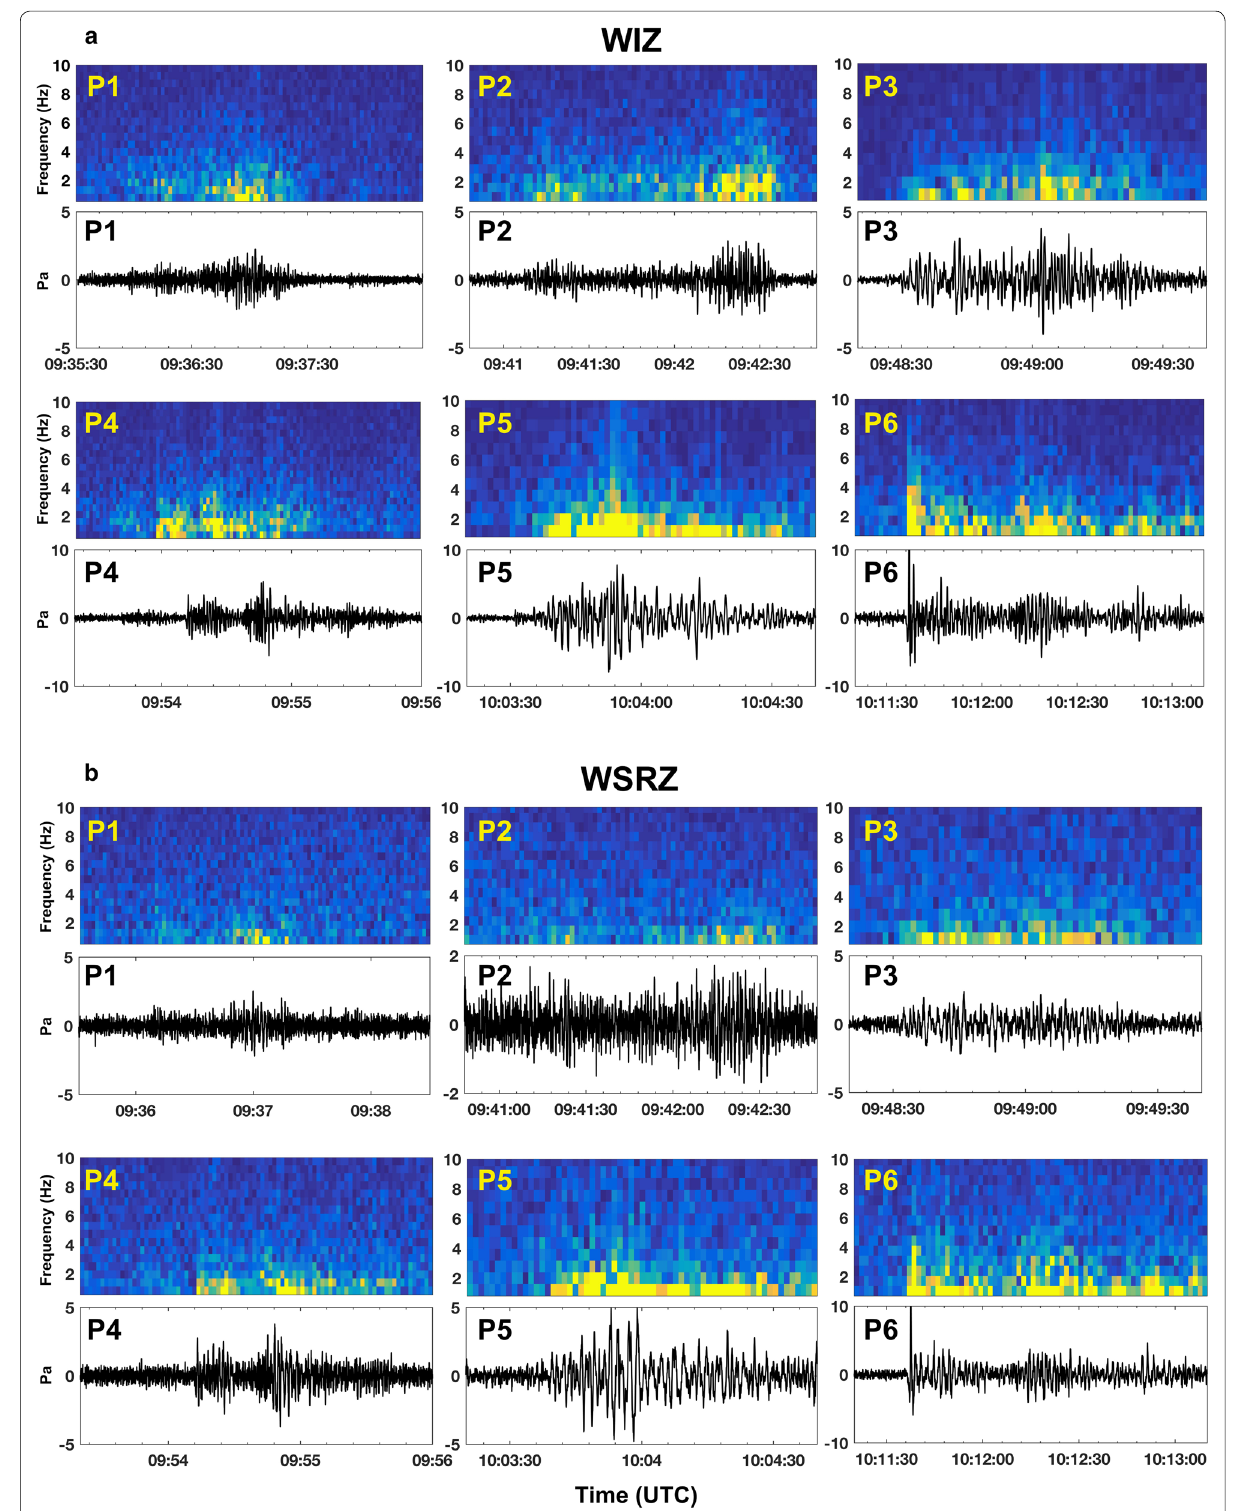
Fig. 4 a Acoustic eruption pulse signals filtered between 0.5 and 10 Hz with corresponding spectrograms for WIZ, b acoustic eruption pulse signals filtered between 0.5 and 10 Hz with corresponding spectrograms for